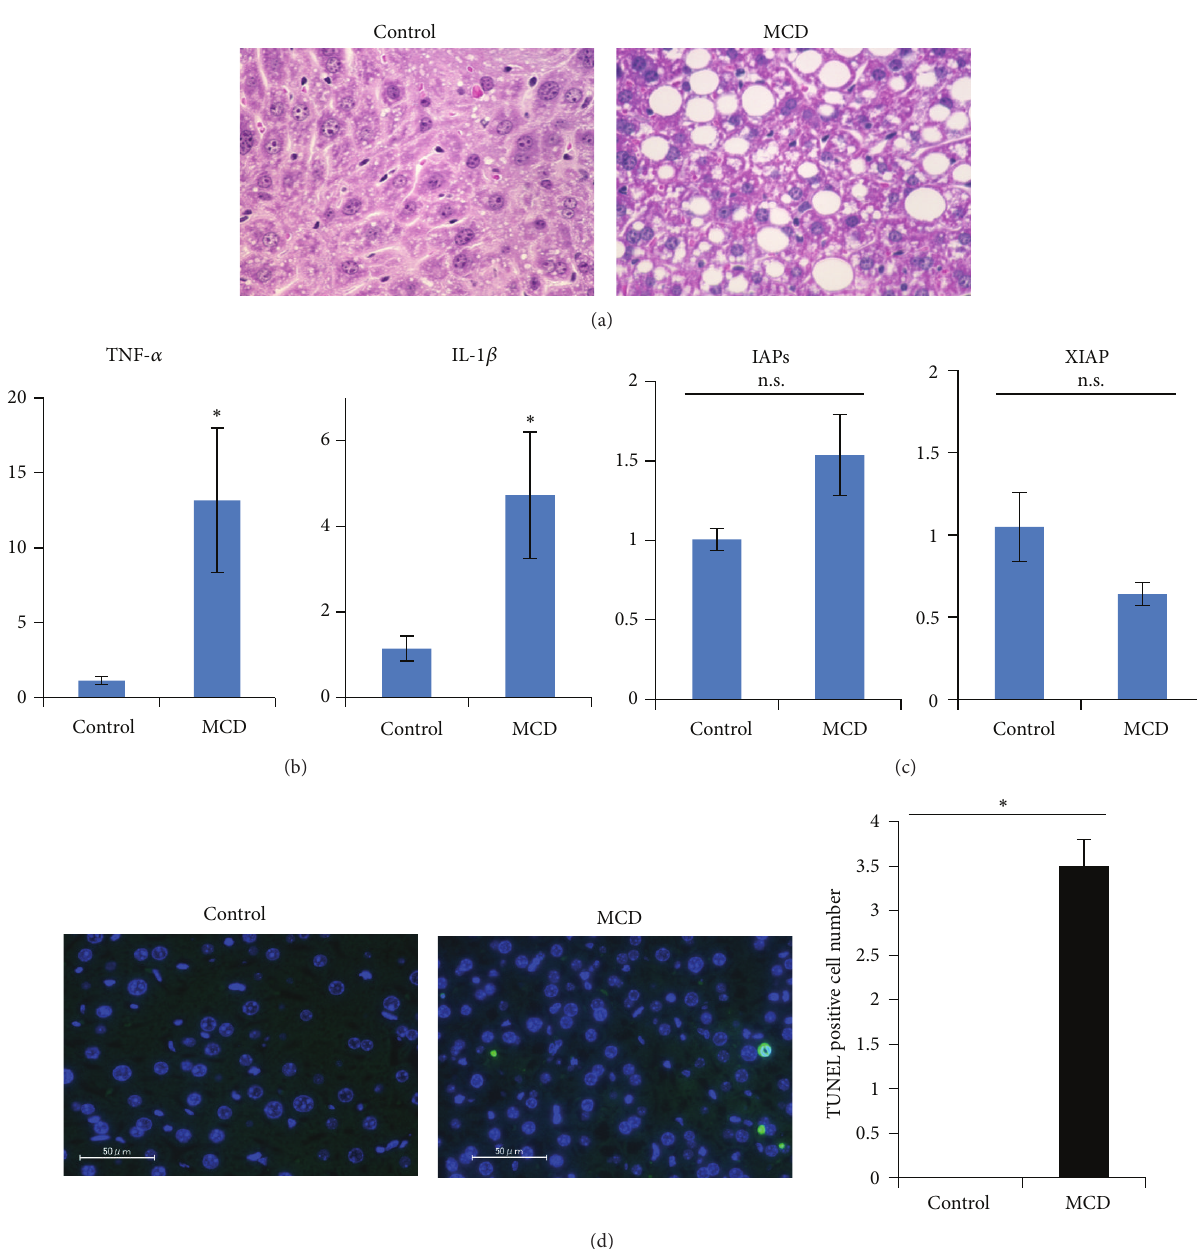
Figure 1: Eight-week-old mice were fed the control or the MCD diet for 8 weeks. Their livers were removed and then used for the experiments. (a) Paraffin-embedded sections were stained with hematoxylin and eosin. (b, c) RNA was isolated from the livers and mRNA levels of inflammatory cytokines (TNF- 𝛼 and IL-1 𝛽 ) and antiapoptosis factors (IAPs and XIAP), regulated by the NF- 𝜅 B transcriptional activity, were determined by real-time PCR using primers corresponding to their mRNA sequences ( 𝑛 = 5 ). The data were normalized with the expression of GAPDH mRNA. (d) Apoptotic cell death in livers was detected by TUNEL staining. The data shown are representative of three to five independent experiments and shown as means ± S.E.M. ∗ 𝑝 < 0.05